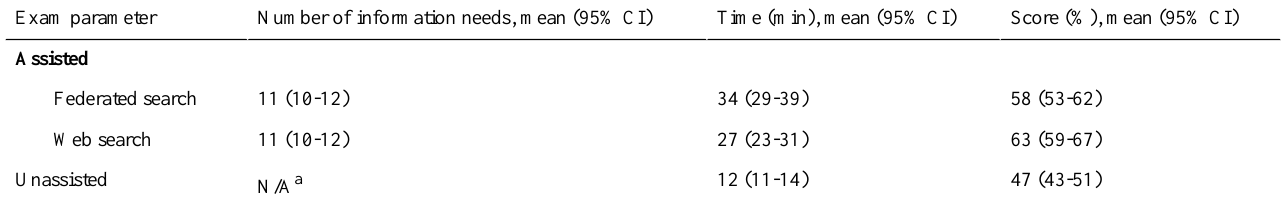
Table 2. Results of the examination-level analysis for the 3 experimental conditions including the mean examination score, duration, and number of information needs for the assisted conditions (with 95% CI).